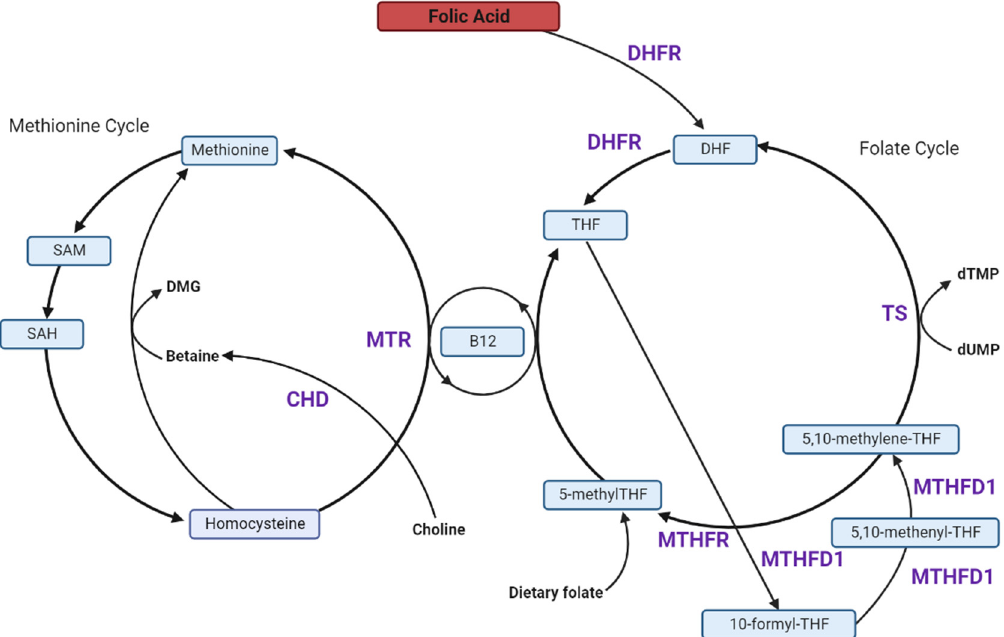
Figure 1. Overview of one-carbon metabolism. Folic acid (FA) is reduced via dihydrofolate reductase (DHFR) to dihydrofolate (DHF) and sequentially tetrahydrofolate (THF) [58]. THF is interconverted to intermediate metabolites 10-formyltetrahydrofolate (10-formylTHF), 5,10-methenyltetrahydrofolate (5,10-methenylTHF and 5,10-methylenetetrahydrofolate (5,10-methyleneTHF), Methylenetetrahydrofolate dehydrogenase (MTHFD1) regulates conversion of THF. After conversion of THF to 5,10-methyleneTHF), a substrate of methylenetetrahydrofolate reductase (MTHFR), 5,10-methyleneTHF can be used in the conversion of deoxyuridine monophosphate (dUMP) to deoxythymidine monophosphate (dTMP) via thymidylate synthase (TS). Alternatively, MTFHR converts 5,10-methyleneTHF to 5-methylTHF. 5-methylTHF is used for homocysteine re-methylation to methionine and is reliant on vitamin B12 (B12)-dependent methionine synthase (MTR). Methionine is converted to S-adenosylmethionine (SAM), a methyl donor in methylation reactions, and sequentially to S-adenosylhomocysteine (SAH), a substrate of homocysteine re-methylation. Alternatively, betaine derived from choline catalysed by choline dehydrogenase (CHD), can be used as a methyl donor in homocysteine re-methylation in a folate-independent manner. After donating a methyl group, betaine becomes dimethylglycine (DMG) Adapted from [16].